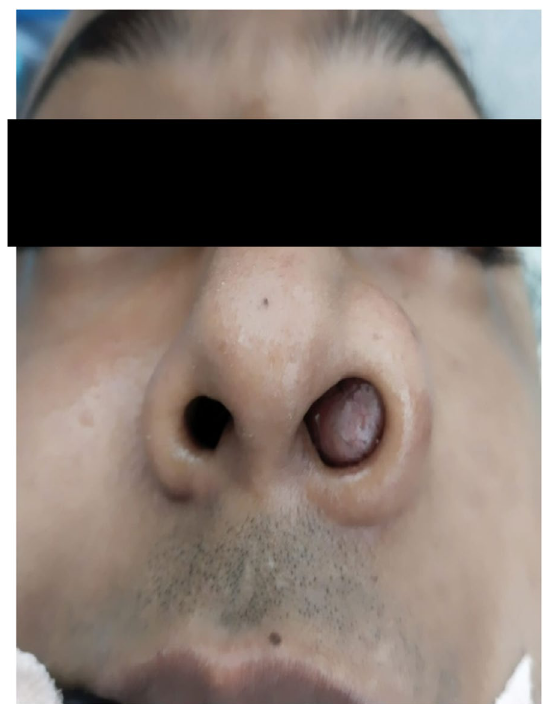
Fig. 1 Mass arising from left nasal cavity causing unilateral nasal obstruction